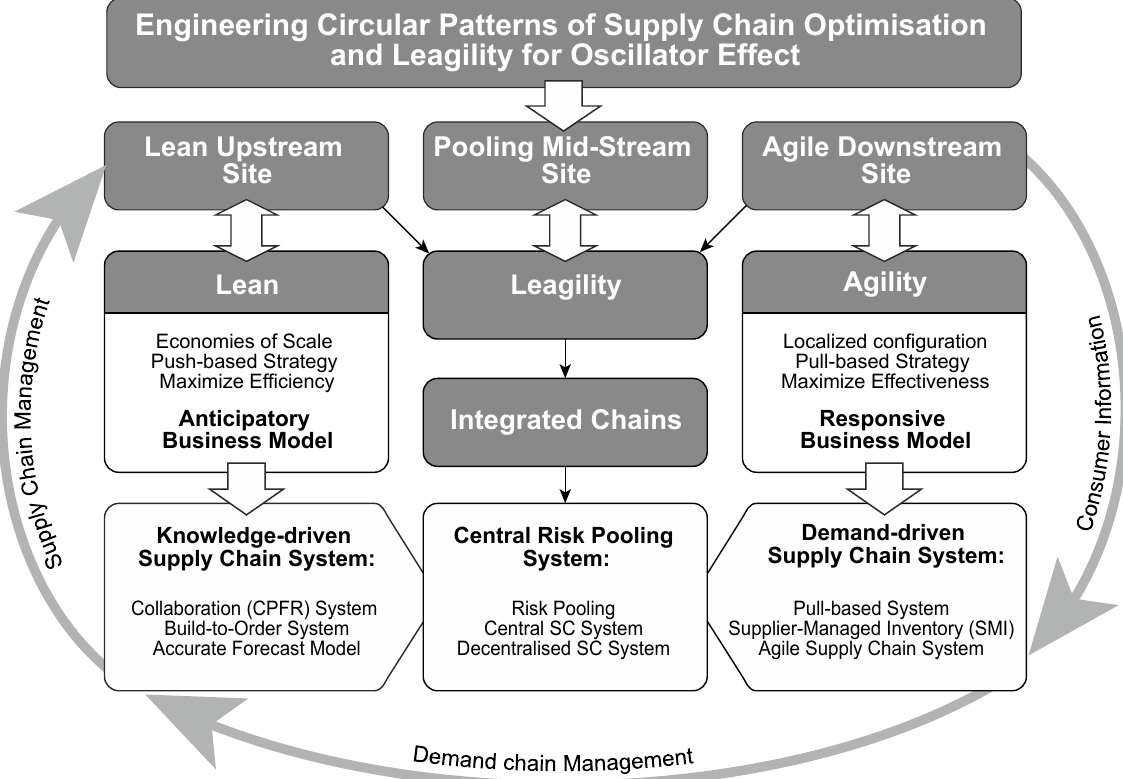
Figure 3. Engineering circular patterns of supply chain optimization strategies and leagility system